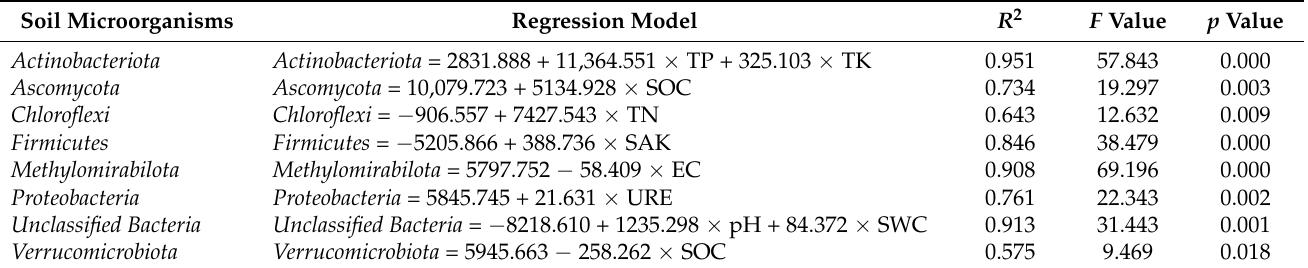
Table A4. Stepwise regression analysis model of soil dominant microorganisms and environmen- tal factors.